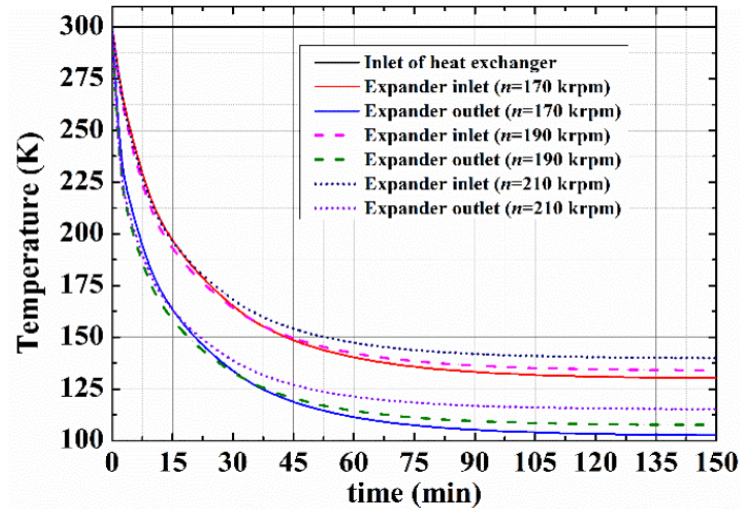
Figure 18. Turbo ‐ compressor ‐ based refrigerator dynamic cooling characteristic [20]. Figure 18. Turbo-compressor-based refrigerator dynamic cooling characteristic